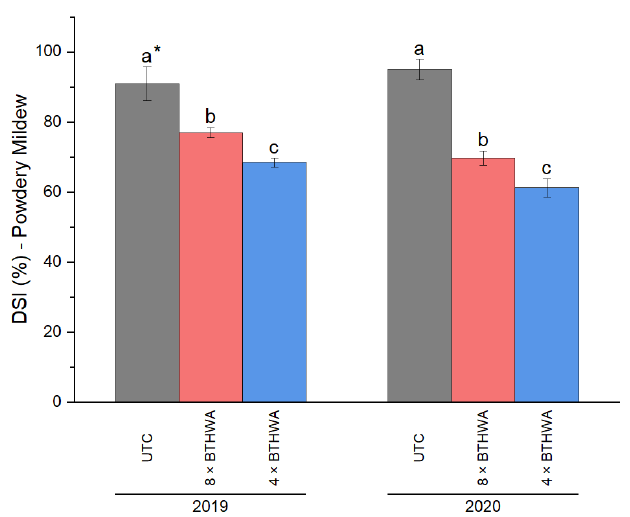
Figure 4. The Disease Severity Index (DSI%) for zucchini ( Cucurbita pepo convar. giromontiina ) infected with powdery mildew. Statistical differences appeared between the plants subjected to different variants of treatments in respective years (treatment × years). * means followed by different letters indicate a statistically significant difference at p < 0.05 according to Tukey’s HSD ( n = 4). UTC — Untreated Control plants that were not treated with BTHWA, 8 × BTHWA — plants that were treated with BTHWA eight times, 4 × BTHWA — plants that were treated with BTHWA four times.